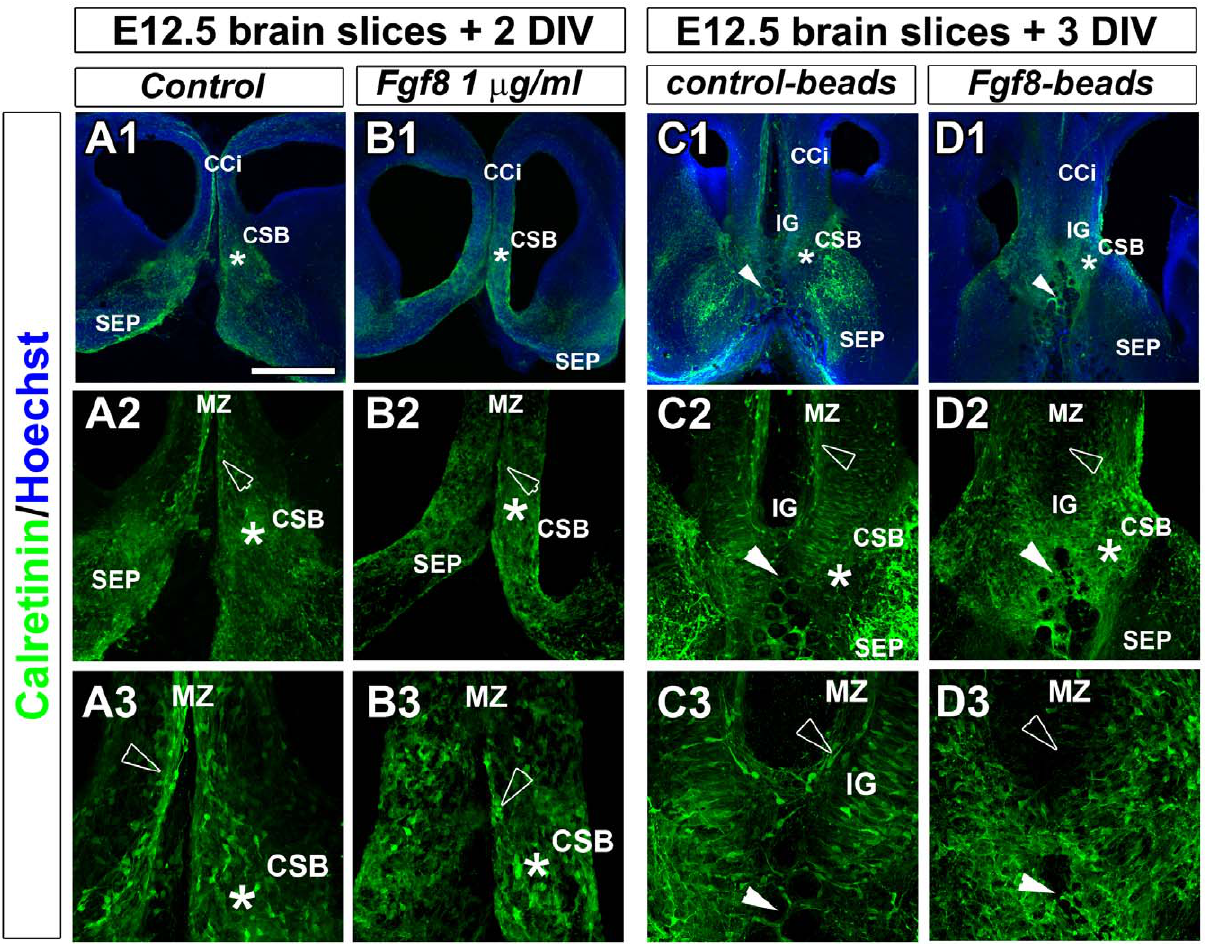
Figure 8. Fgf8 ectopic expression causes severe guidepost neurons mislocalization at the midline. Immunohistochemical staining for calretinin in control (A1–A3, C1–C3) and FGF8-treated (B1–B3, D1–D3) coronal CC organotypic sections. (A2–A3, B2–B3, C2–C3, D1–D3) are higher power views of the CSB region (*) seen in (A1, B1, C1, D1). In control conditions, after BSA bath application (A1–A3) or after implanting BSA-coated beads in the rostromedial pallium (white arrowheads) (C1–C3), neurons labelled with calretinin are properly positioned in cortical layers and at the CSB (*) as it is observed in vivo . By contrast, FGF8 bath application (B1–B3) or FGF8-coated beads implantation in the rostromedial pallium (white arrowheads) (D1–D3) results in the complete disorganization of calretinin-positive neurons that are dispersed in the entire rostromedial pallium. They failed to form a proper structure at the CSB, in the IG and to organize in layers within the cortex. They disappear at the MZ or form aggregates (arrowheads). Bar=435 m m in A1, B1, C1, D1; 220 m m in A2, B2, C2, D2; 110 m m in A3, B3, C3,